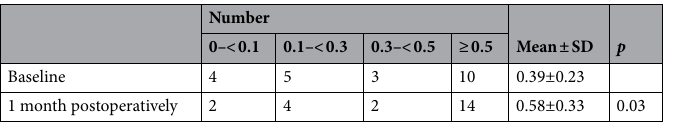
Table 3. Best corrected visual acuity before surgery and 1 month after surgery. SD standard deviation.